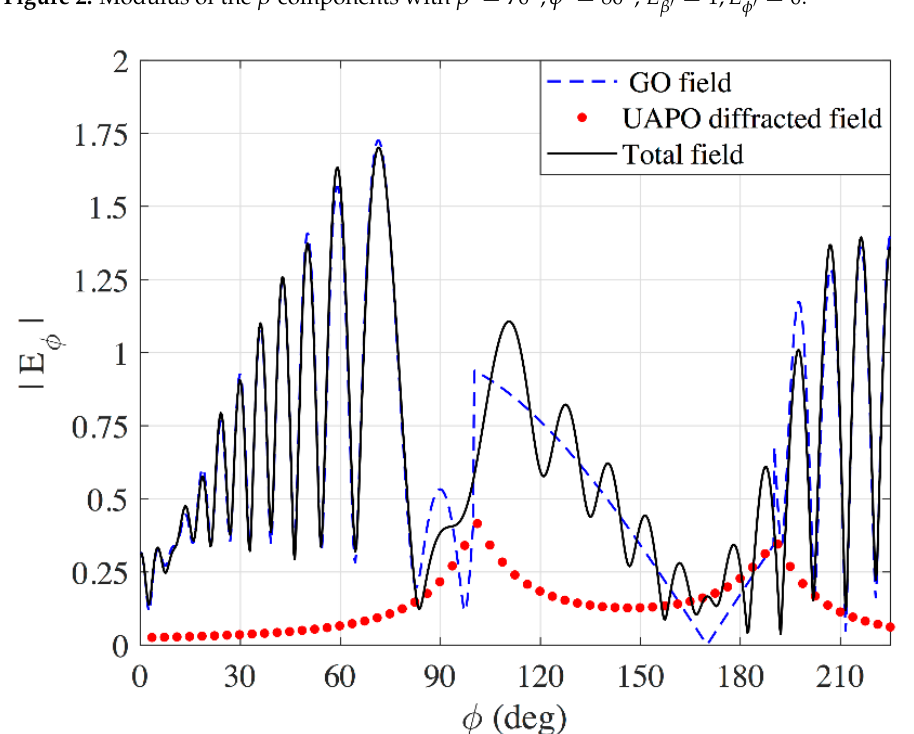
i = i = 1 , E 0 . b ' f ' i = i = = 1, E i = 0. 1 , E 0 . φ (cid:48) β (cid:48) b ' f '